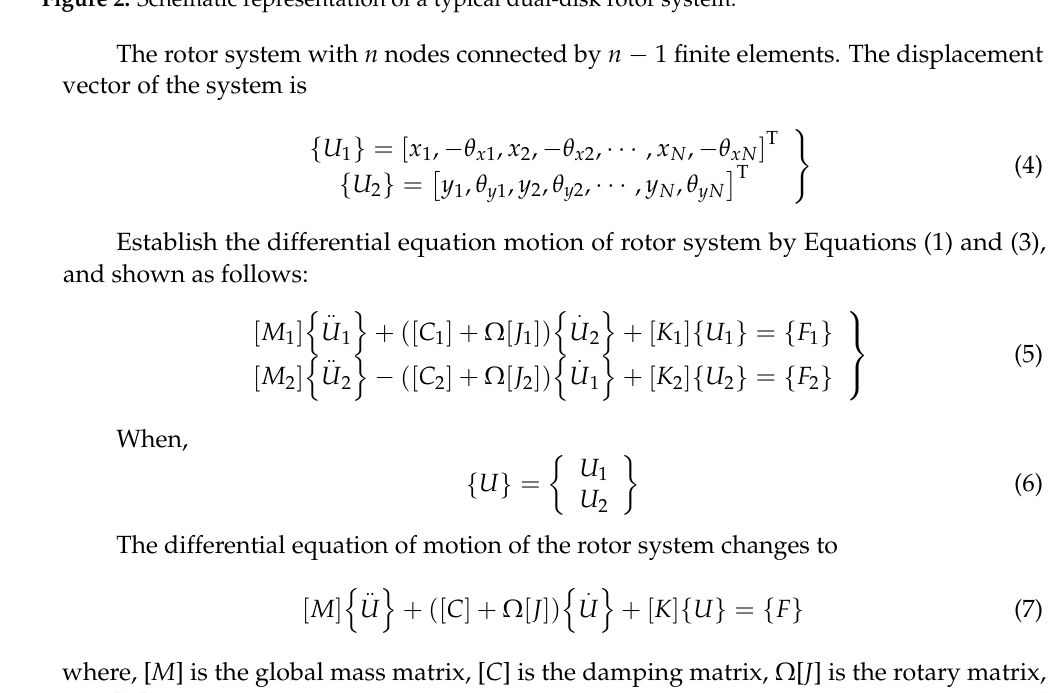
Figure 2. Schematic representation of a typical dual-disk rotor